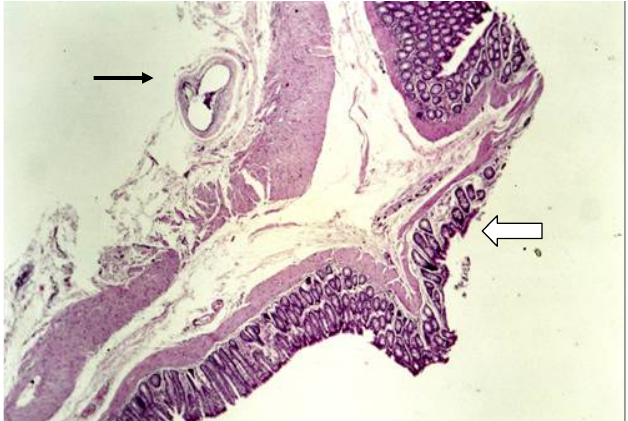
FIGURE 3 – Mucosa projection over the intestinal serosa, colonic valve (large arrow), at the muscular layer interruption. Giant cell reac- tion to foreign body at serosa (arrow). Hematoxilin and Eosin color. 10 X Zoom/close-up